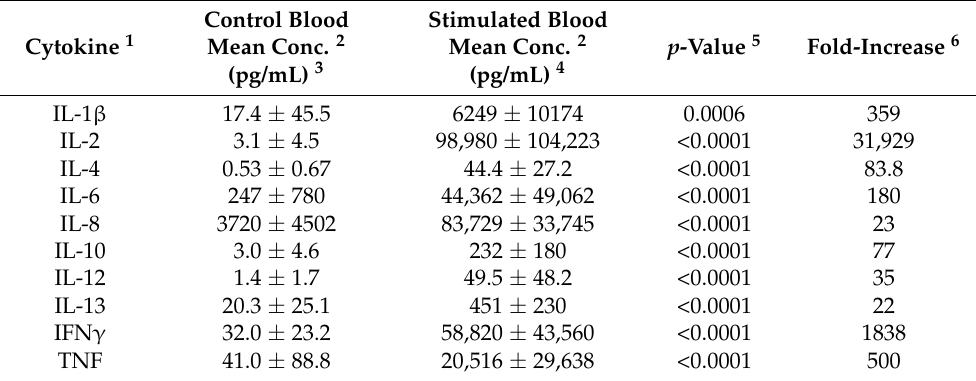
Table 3. Cytokine release after in vitro antigenic stimulation of infant whole blood.